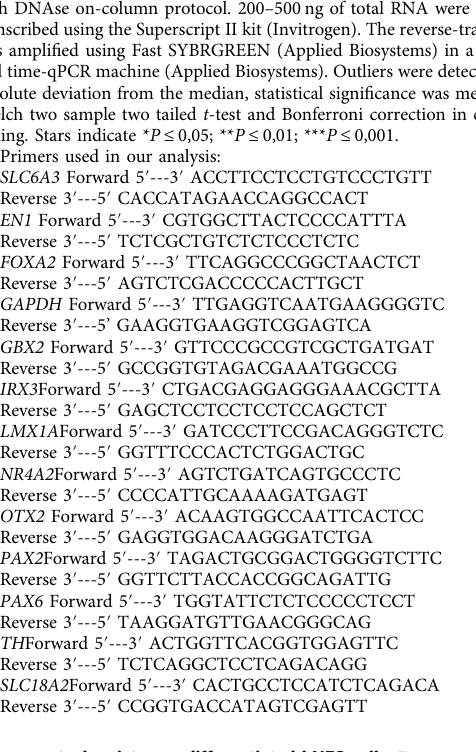
(PFA) in PBS, permeabilized and blocked for 60min in PBS containing 0.3% Triton X-100, 0.1% BSA and 10% normal donkey serum (PBTA-NDS). Then they